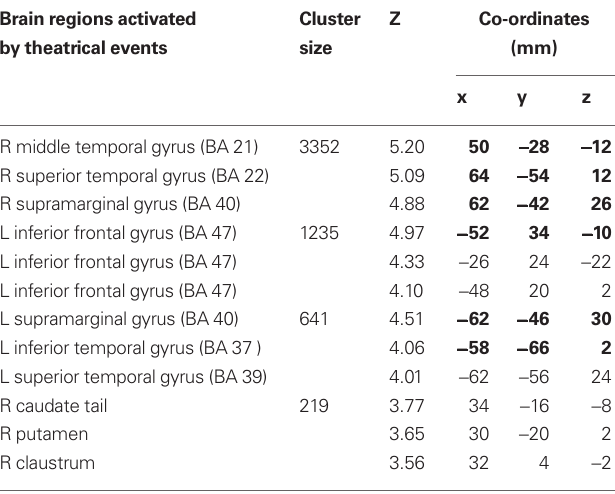
Table 1 | Brain regions significantly activated in response to theatrical events relative to the